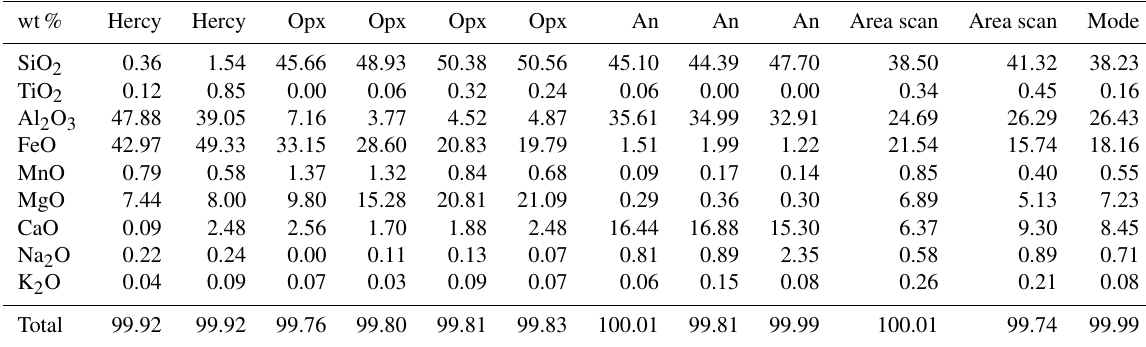
Table 2. Phases in symplectite in sample 13H – energy dispersion spectroscopy (EDS)